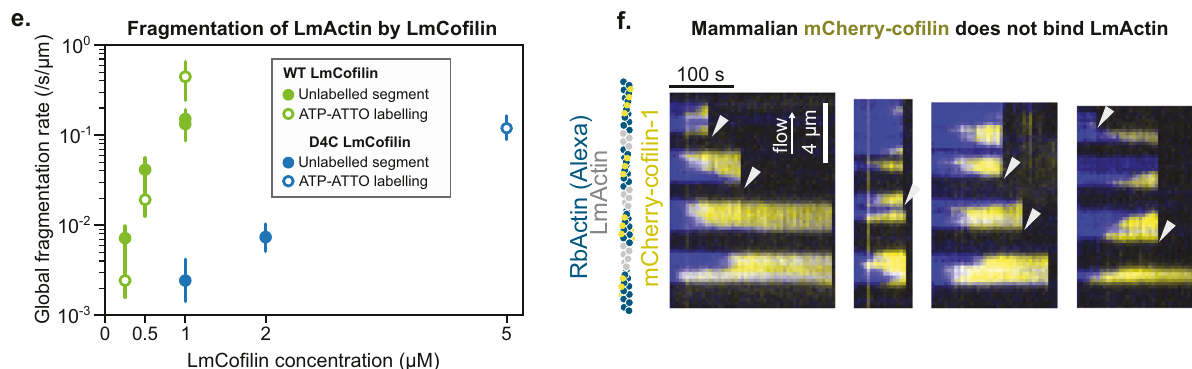
Fig. 6 Structural basis of Leishmania actin fi lament severing. a Structure of the LmActin fi lament decorated with Leishmania co fi lin. In comparison to vertebrate co fi lin (in red), the Leishmania co fi lin (in cyan) contains an extended C-terminal α -helix. b A close view of the C-terminal region of co fi lin. In vertebrate co fi lin, C-terminus forms a turn followed by a two-strand β -sheet, which stabilizes loop 91 – 96 to closer contact with the actin fi lament. This β - sheet is absent from Leishmania co fi lin, which contains an extended C-terminal α -helix. c Amino acid contacts between the C-terminus of Leishmania co fi lin and LmActin. The acidic C-terminus can form an ion pair with Arg210 in actin, and local hydrophobic contacts through Val139 to Met16 and Val30. His136 and Arg137 can form ion bonds to Asp288 and Asp56, respectively, in actin. d The N-terminus of Leishmania co fi lin interacts with the barbed end of actin. In the co fi lin-bound actin, the D-loop is unstructured (not shown in the fi gure), whereas in bare actin fi laments the D-loop (shown in yellow) associates with the hydrophobic pocket (residues named in white) of the adjacent actin subunit. Hydrophobic Ile2 from Leishmania co fi lin collides with Met45 of D- loop, and is thus expected to replace the D-loop from the hydrophobic pocket. In vertebrate co fi lin (cyan), the N-terminal tracing of the structure terminates to Ser3. e Global severing rates of wild-type Leishmania co fi lin (data from Fig. 5b) and a mutant Leishmania co fi lin lacking the four C-terminal amino acids (D4C). Each data point was calculated by fi tting the survival fraction of >60 F-actin segments ( n ) with a single exponential and normalized by the mean segment length (units: /s/ µ m, see Methods). Error bars were calculated by fi tting the upper and lower values of the 95% con fi dence interval. For unlabeled segments with wild-type LmCo fi lin: 0.25 µ M N = 1, n = 90; 0.5 µ M N = 1, n = 90; 1 µ M N = 2, n = 90, 90. For ATP-ATTO labeled segments with wild-type LmCo fi lin: 0.25 µ M N = 1, n = 20; 0.5 µ M N = 1, n = 20; 1 µ M, N = 1, n = 20. For unlabeled segments with D4C LmCo fi lin: 1 µ M N = 1, n = 90; 2 µ M N = 1, n = 240. For ATP-ATTO labeled segments with D4C LmCo fi lin: 5 µ M N = 1, n = 60. f Decoration and fragmentation of segmented fi laments (Alexa-RbActin segments in blue, and unlabeled LmActin segments) by 200 nM vertebrate mCherry-co fi lin-1 (yellow) from a single experiment. No decoration by mCherry-co fi lin-1 is observed on unlabeled LmActin segments. The severing of fi laments appears to occur mainly at the interface between LmActin and rabbit actin segments